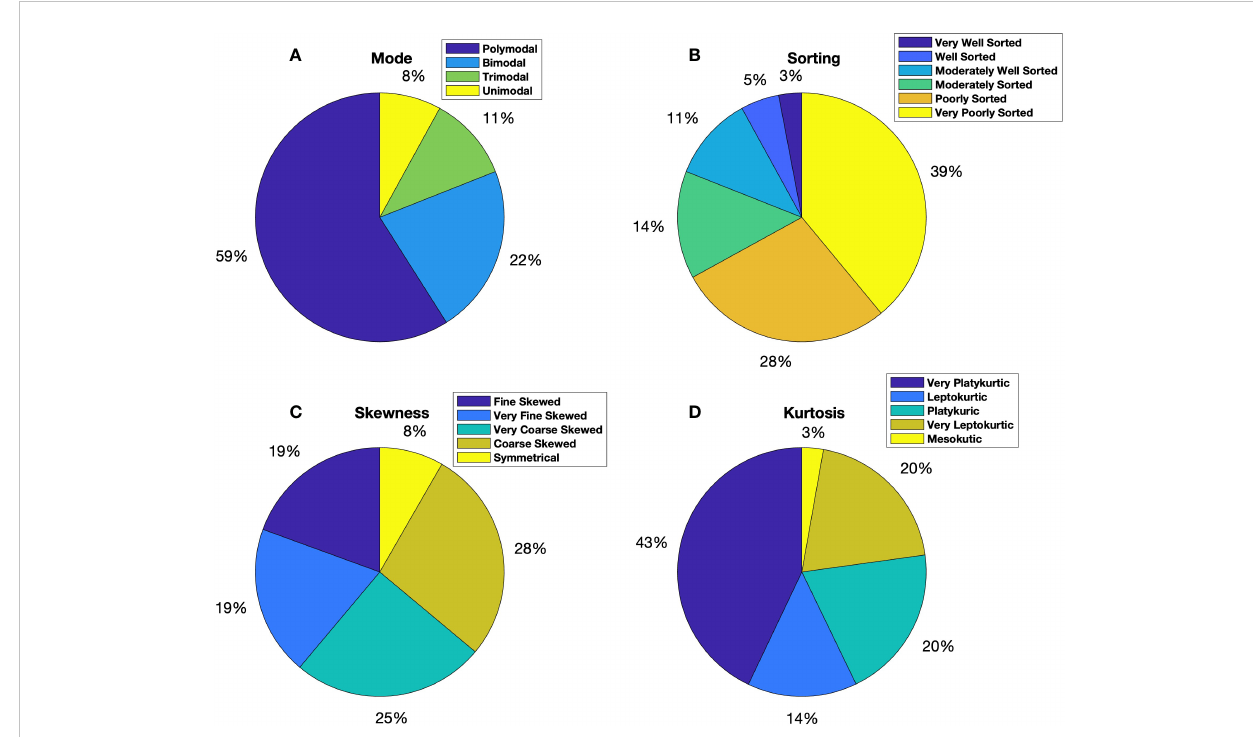
FIGURE 4 The percentage of Grain-Size (A) Mode, (B) Sorting, (C) Skewness and (D) Kurtosis across the study area.